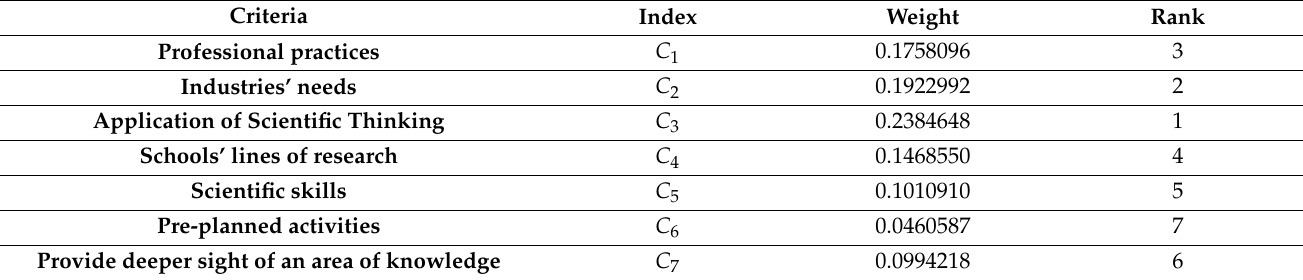
Table 7 describes the criteria weights and their ranks: Table 7. Criteria weights using